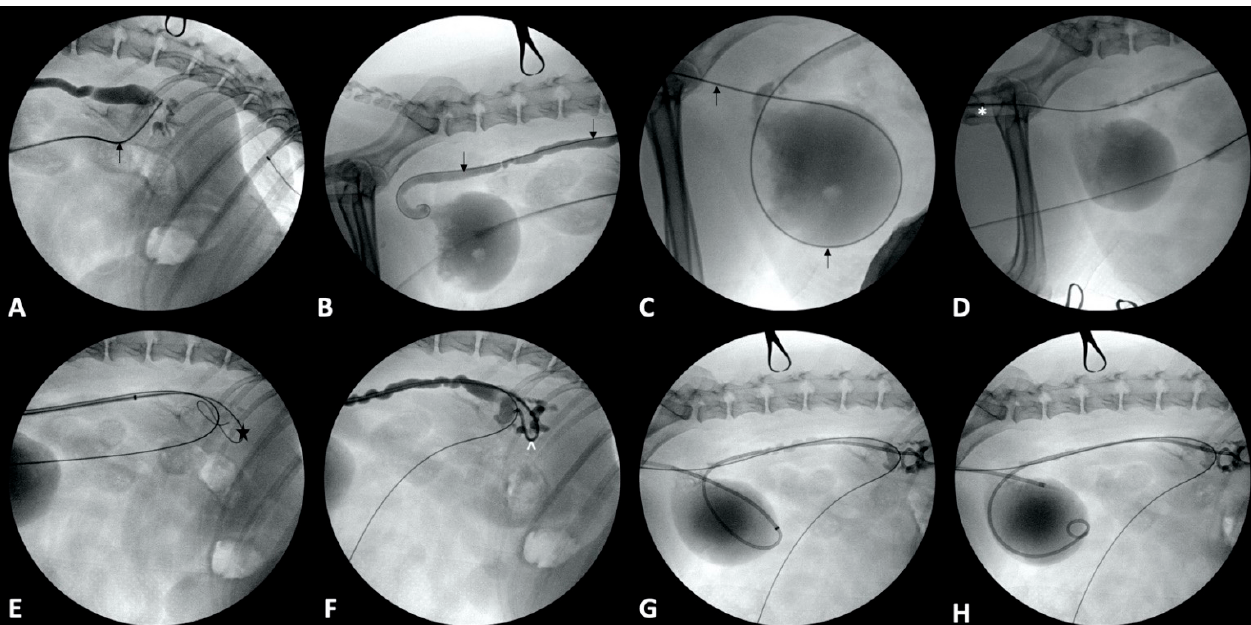
Figure 1. An 18-gauge over-the-needle catheter has been inserted into the renal pelvis of a dog in lateral recumbency, and a contrast nephroureterogram has been performed using fluoroscopic guid- ance.